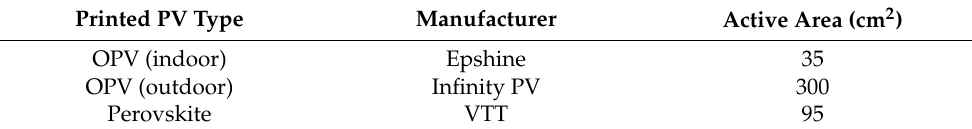
Table 3. Commercially available printed PV cells used for the experiment.